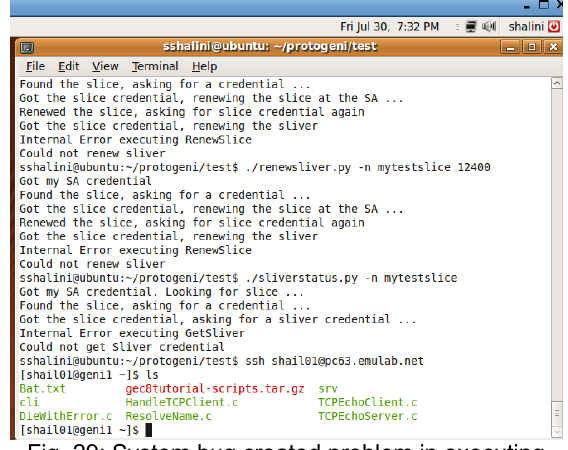
Fig. 29: System bug created problem in executing test